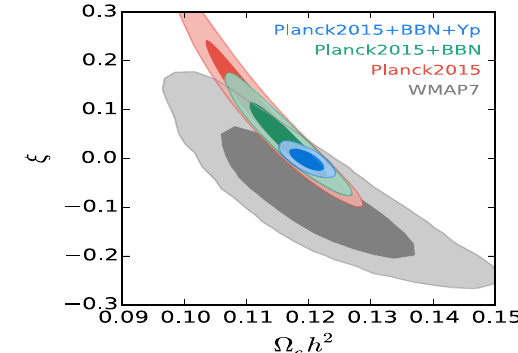
Fig. 3 Marginalized two-dimensional contours in the ξ − (cid:9) c h 2 plane with 68 and 95% confidence level in the extended (cid:19) CDM model with BBN consistency, derived from the data of Planck 2015 + JLA + BAO ( green ) and Planck 2015 + JLA + BAO + Y p ( blue ). The red and gray contours correspond to Y p = 0 . 24, derived from Planck 2015 + JLA + BAO and from WMAP7 + H 0 + BAO [22], respectively 2015” denotes the combination of the low- (cid:16) temperature- polarization likelihood and the high- (cid:16) temperature likeli- hood.